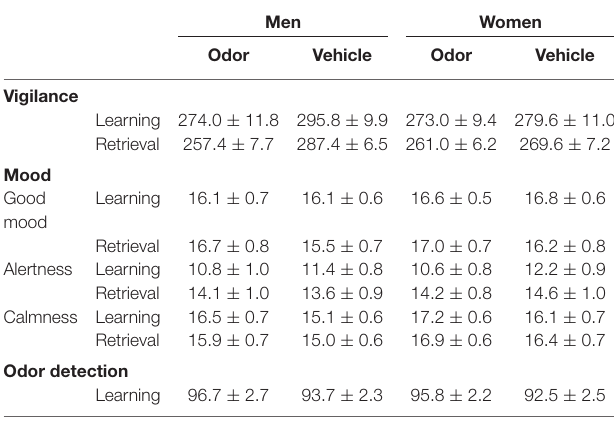
TABLE 2 | Control